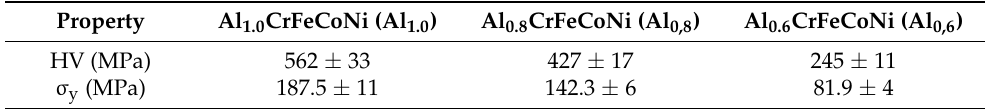
Table 4. Mechanical properties of analyzed